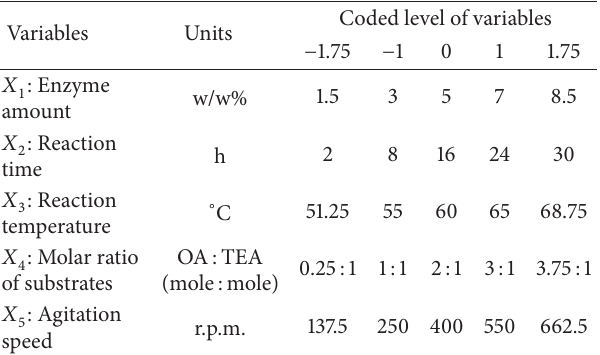
Table1:Variablesandtheirlevelsemployedinthecentralcomposite